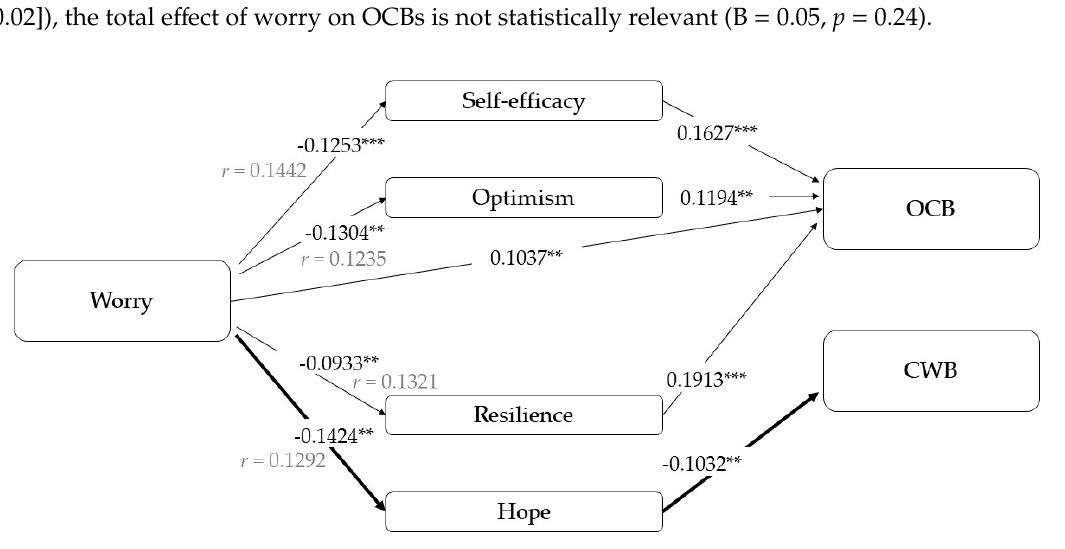
Figure 6. Results of the mediation models with worry as an independent variable. Note: [95% CI]; ** p < 0.01; *** p < 0.001.